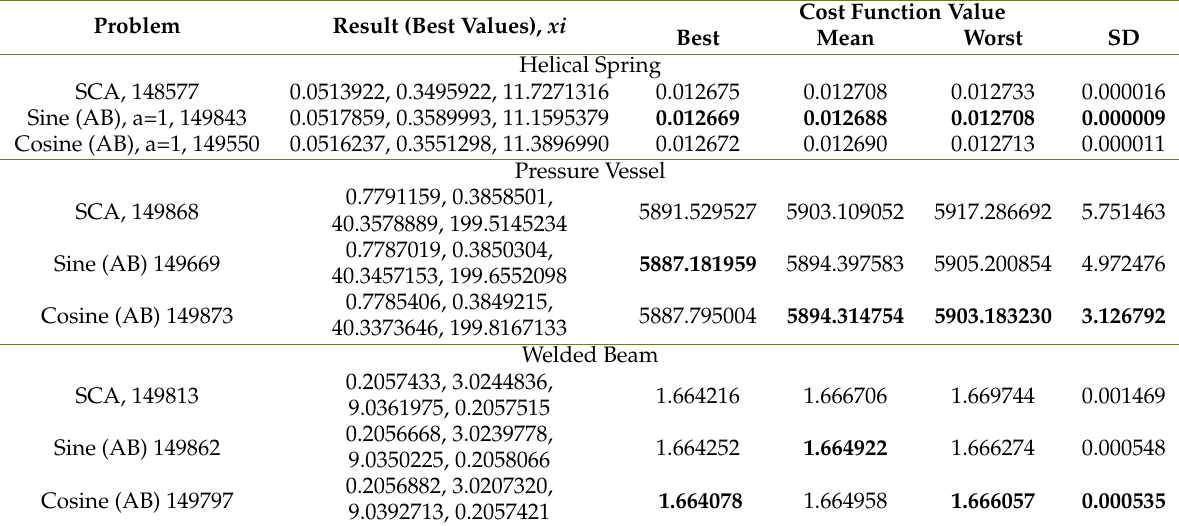
Table 14. Performance in Real Engineering